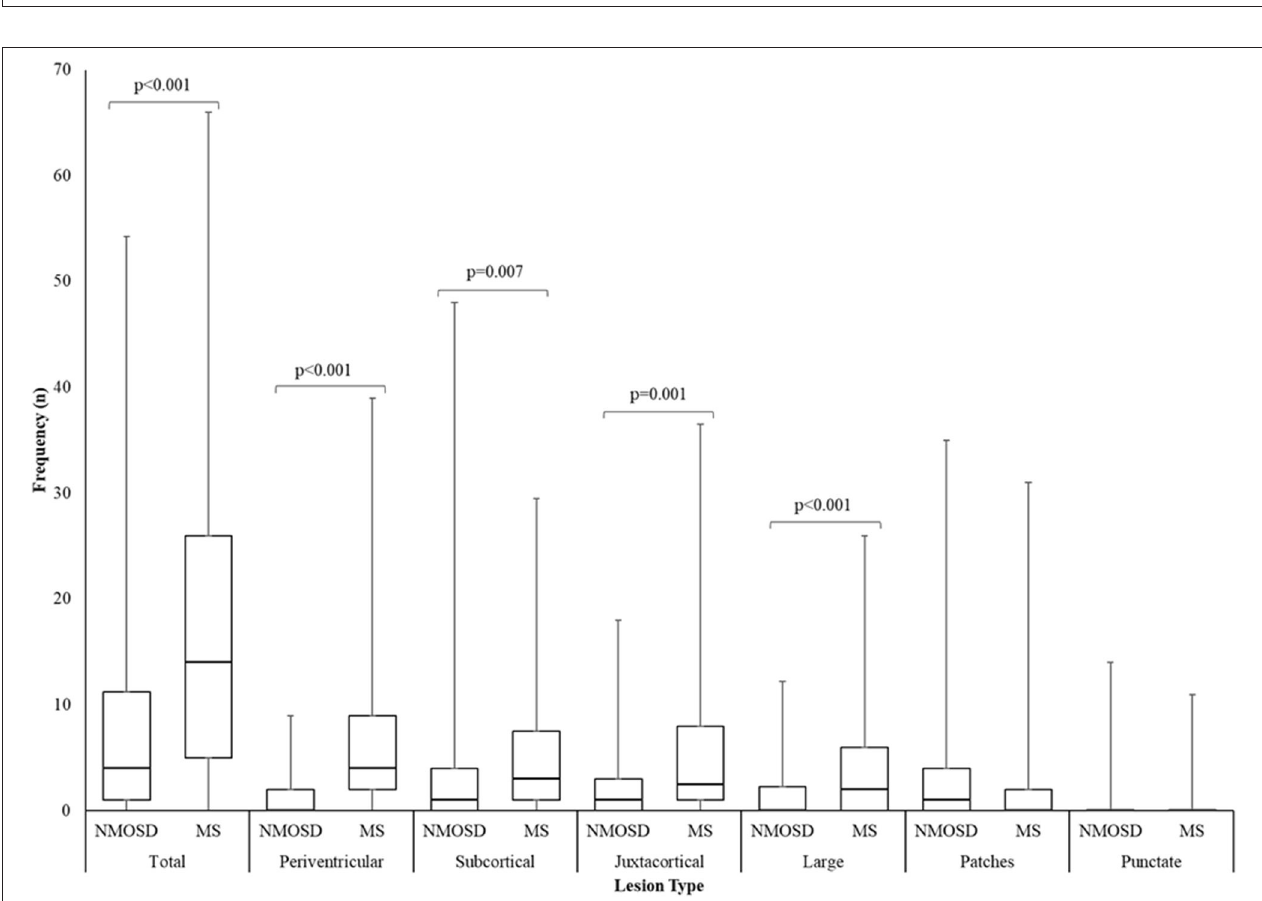
FIGURE 6 | lesions (arrows) on sagittal FLAIR image of the brain (E) ; ovoid hyperintense T2 periventricular lesion (arrow) on axial FLAIR image of the brain (F) ; large supratentorial T2 lesion (arrow) on sagittal FLAIR image of the brain (G) ; Dawson’s finger lesions (arrows) on sagittal FLAIR image of the brain (H) ; right cerebellar peduncle hyperintense T2 lesion (arrow) on axial T2 image of the brain (I) ; pyramidal corpus callosum hyperintense T2 lesion (arrow) on sagittal FLAIR image of the brain (J) ; splenium hyperintense T2 lesion (arrow) on axial (K) and sagittal (L) FLAIR images of the brain; Gd-enhancing T1 lesions of periventricular (arrow) (M) , juxtacortical (arrows) (N) , splenium (arrow) (O) regions on axial T1 images of the brain and ring-enhancing lesion (arrow) on coronal T1 image of the brain (P) ; hypointense T1 (black hole) lesions (arrows) on axial T1 image of the brain (Q) ; short segment C3 T2 lesion (arrow) on sagittal T2 image of the cervical spinal cord (R) ; and hyperintense T2 partial cord lesion (arrow) on axial T2 image of the cervical spinal cord (S) .